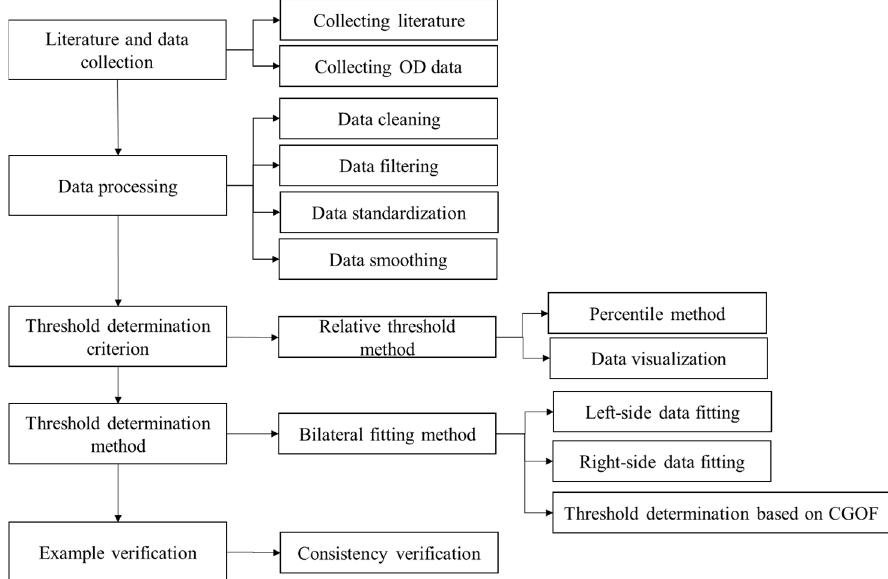
Figure 1. Technology